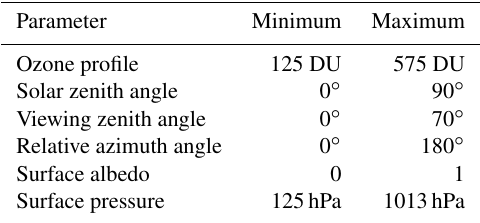
Table 1. Ranges of input parameters appropriate for radiance sim- ulations in the total ozone fitting window; ozone profiles are classi- fied as a function of the total column. Smart sampling is employed to generate node points optimally covering all input dimensions, and more than 2 × 10 5 synthetic UV spectra are